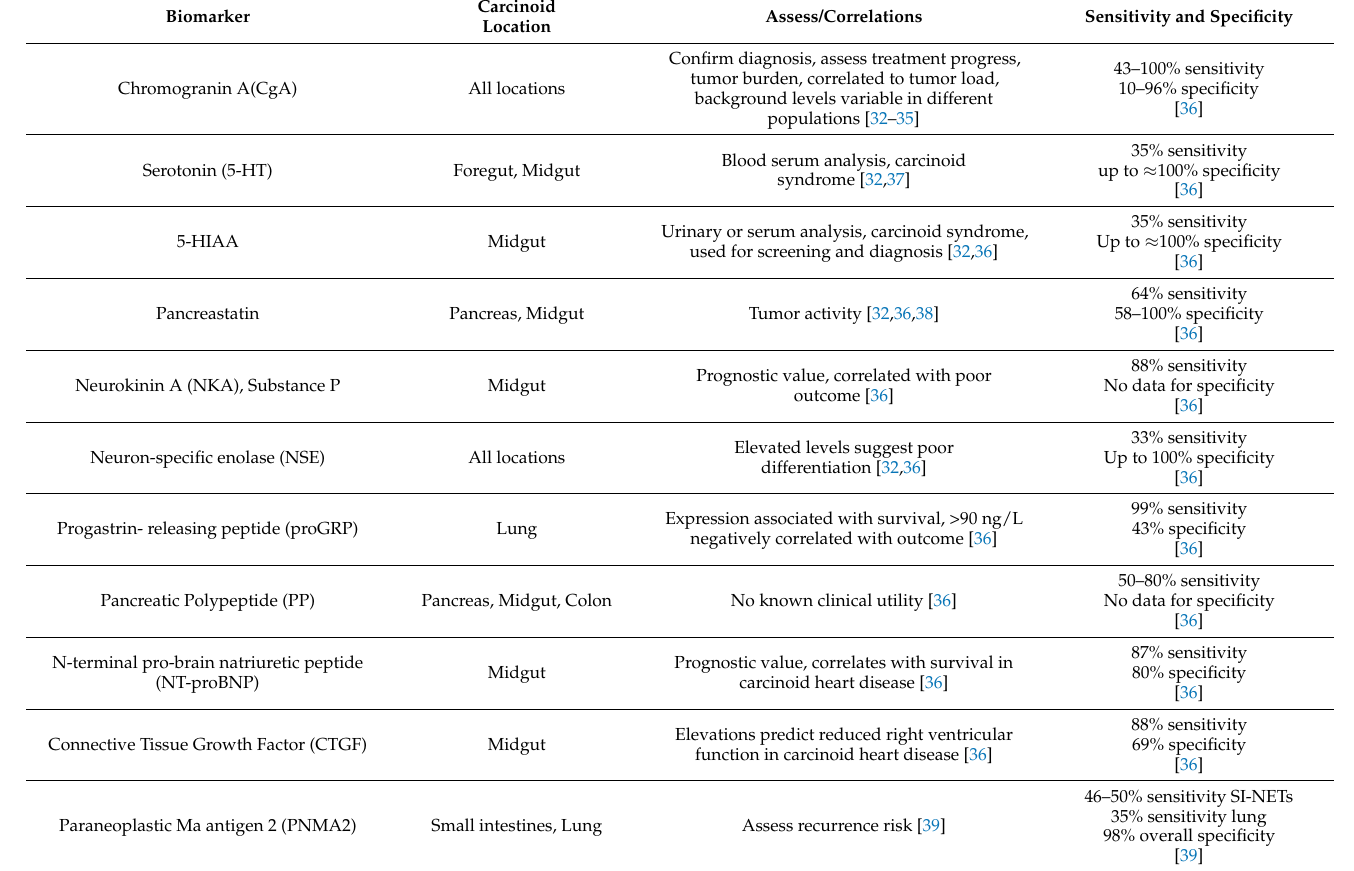
Table 1. Monoanalyte Carcinoid